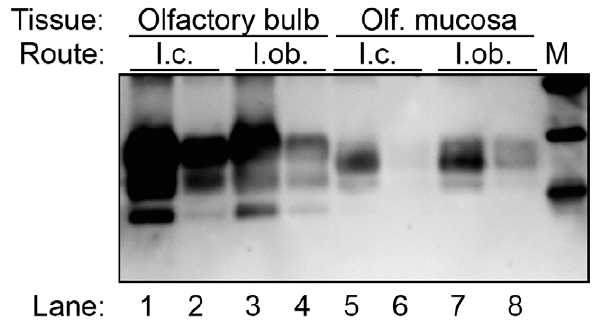
Figure 2. Western blot for PrP Sc in olfactory bulb and olfactory mucosa following HY TME infection of hamsters. Olfactory bulb (lanes 1 to 4) and olfactory mucosa (lanes 5 to 8) lysates from clinical HY TME hamsters following intracerebral (lanes 1, 2, 5 and 6) and intra- olfactory bulb (lanes 3, 4, 7, and 8) inoculation were enriched for PrP Sc by detergent extraction, ultracentrifugation, and proteinase K digestion. Western blot for prion protein was performed as described in Figure 1. Marker (M) polypeptides correspond to 20, 30, and 40